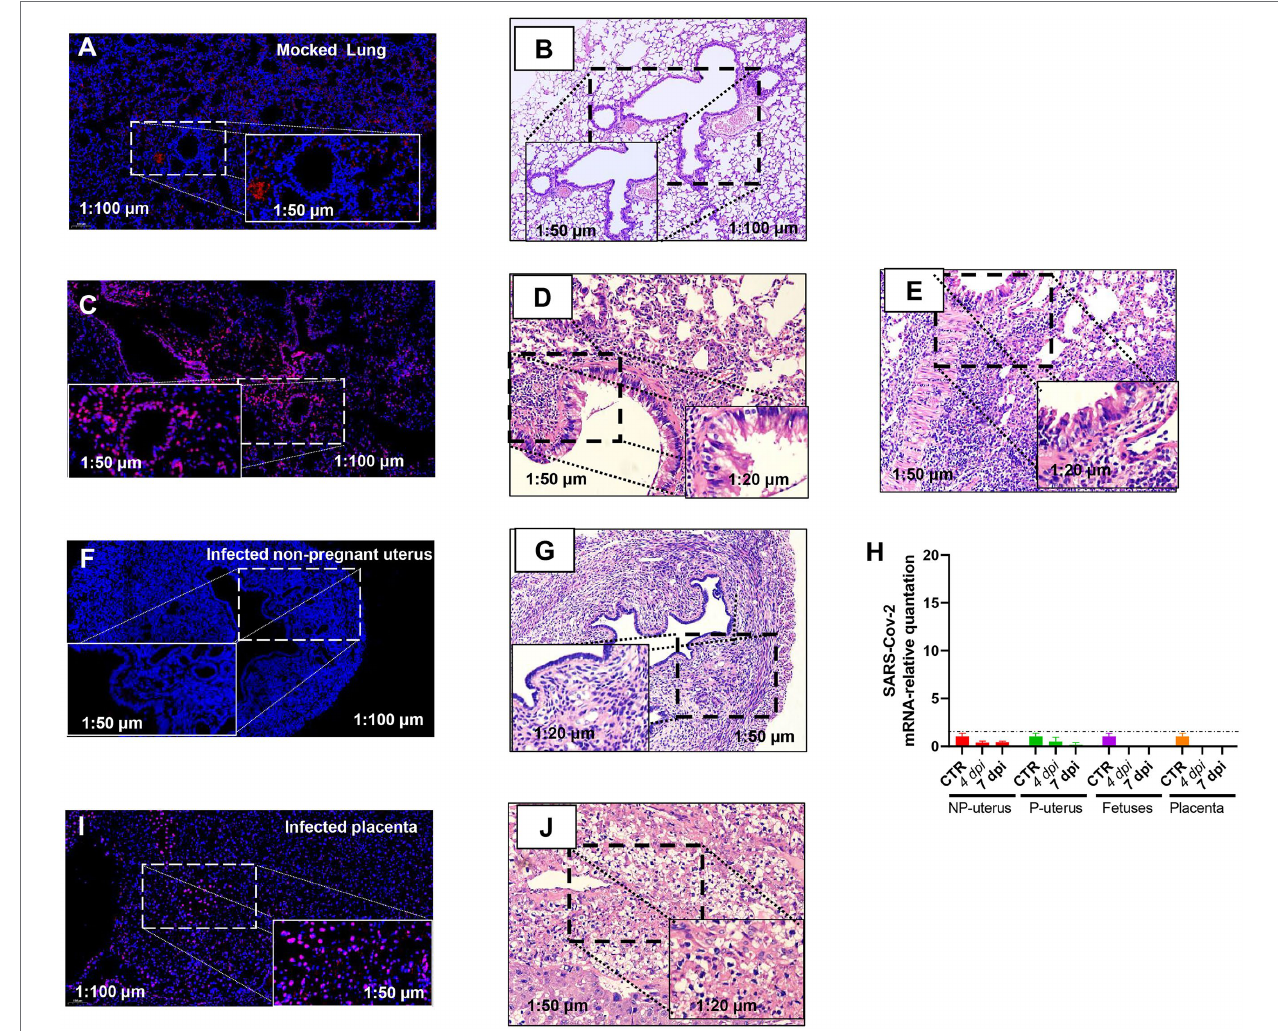
FIGURE 3 | Fluorescence in situ hybridization (FISH) detection of SARS-CoV-2 mRNA. Mock lung (A) and corresponding HE (B) . Infected lung (C) and corresponding HE from the non-pregnant (D) and pregnant (E) mouse. Infected non-pregnant uterus (F) and corresponding HE (G) . (H) The SARS-CoV-2 mRNA relative quantitation of the uterus of non-pregnancy ( n = 6) and pregnancy ( n = 6), fetuses ( n = 3), and placenta ( n = 3) in infected mice. The SARS-CoV-2 RNA in fetuses and placenta had not been detected. NP, non-pregnancy; P, pregnancy; and Infected placenta (I) and corresponding HE (J)